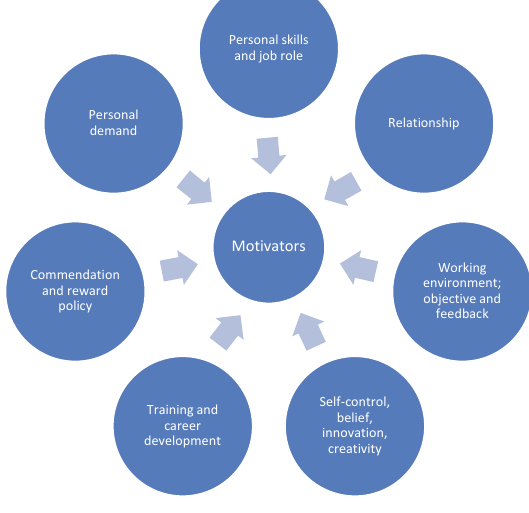
Fig. 3. Factors affecting labor motivation